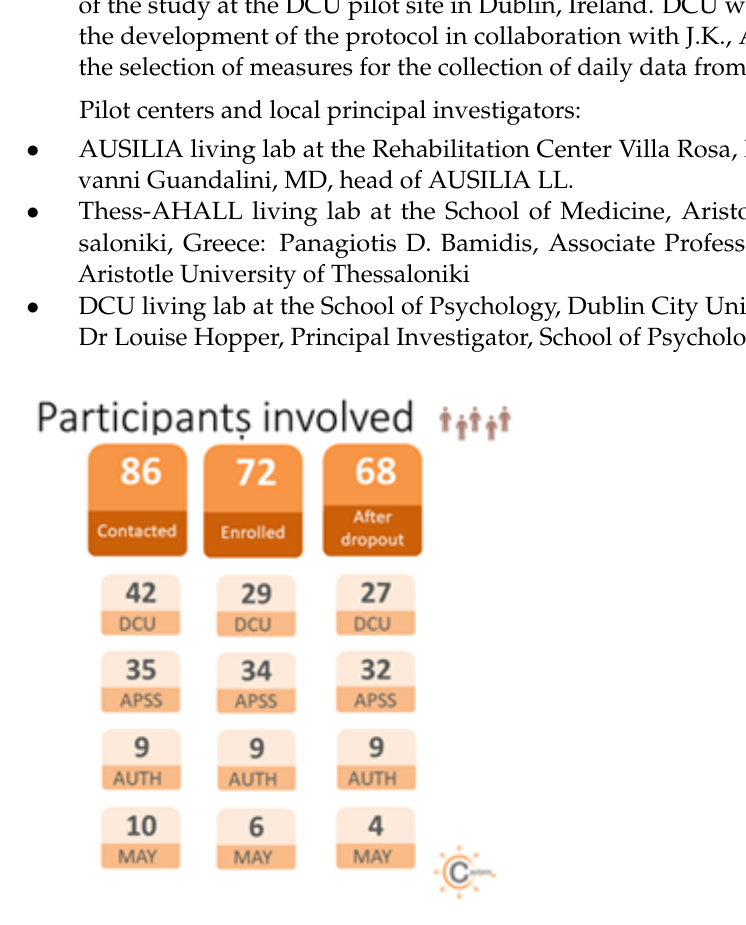
Figure A1. Participant’s involvement scheme.